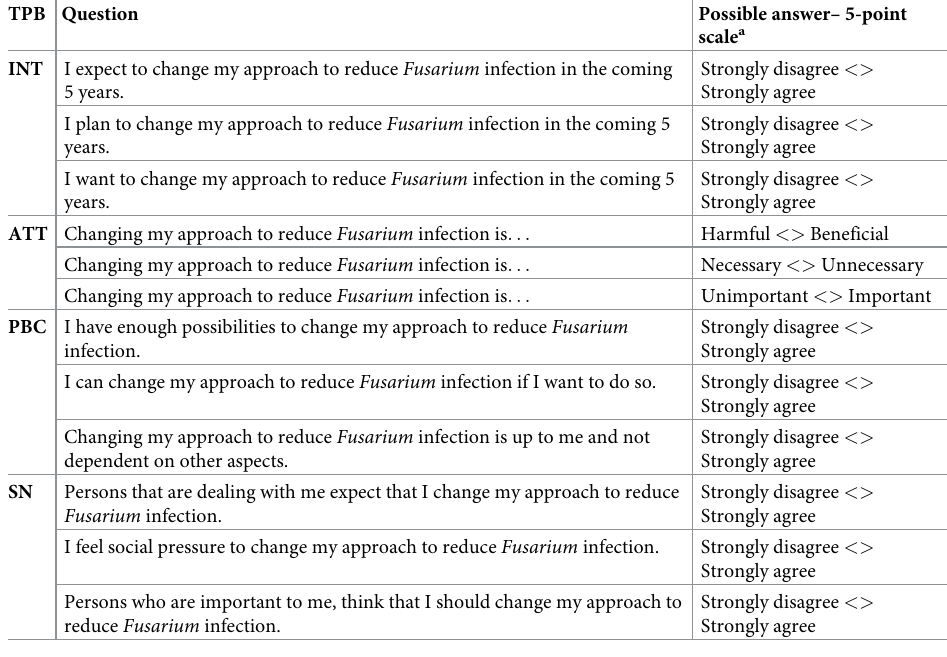
Table 1. Theory of Planned Behaviour (TPB) questionnaire questions and answer formats for intention (INT) and behavioural constructs attitude (ATT), perceived behavioural control (PBC), and social norm (SN). TPB Question Possible answer– 5-point